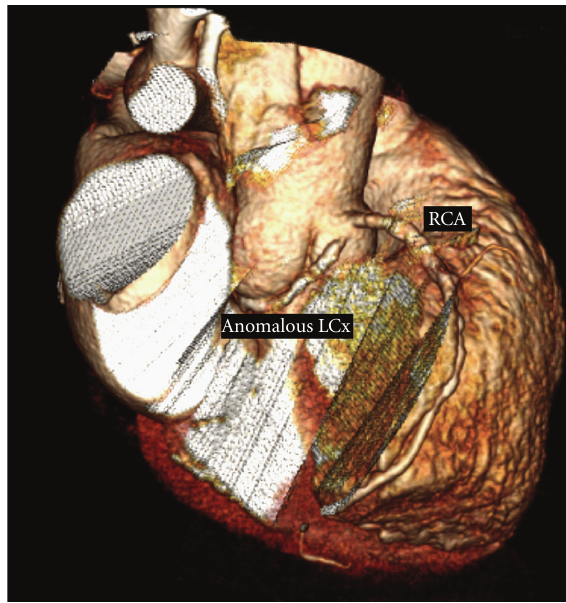
Figure 2: Angio CT showing retro-aortal route of anomalous